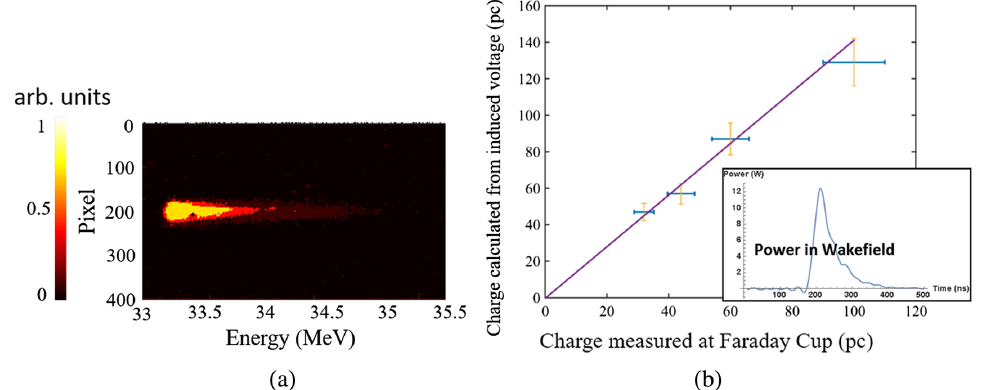
FIG. 11. (a) The peak dark-current energy at simulated gradient of 140 MV = m, and (b) comparison of the measured charge from Faraday cup and calculated using the cavity parameters and the induced wakefield.